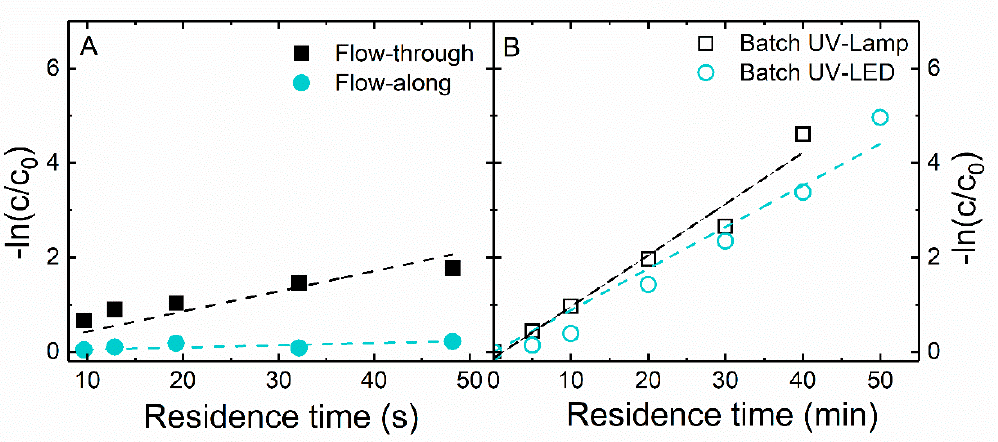
Figure 9. Plot of negative logarithmic relative concentration as a function of residence time: ( A ) flow-through and flow-along reactors, and ( B ) batch reactor.